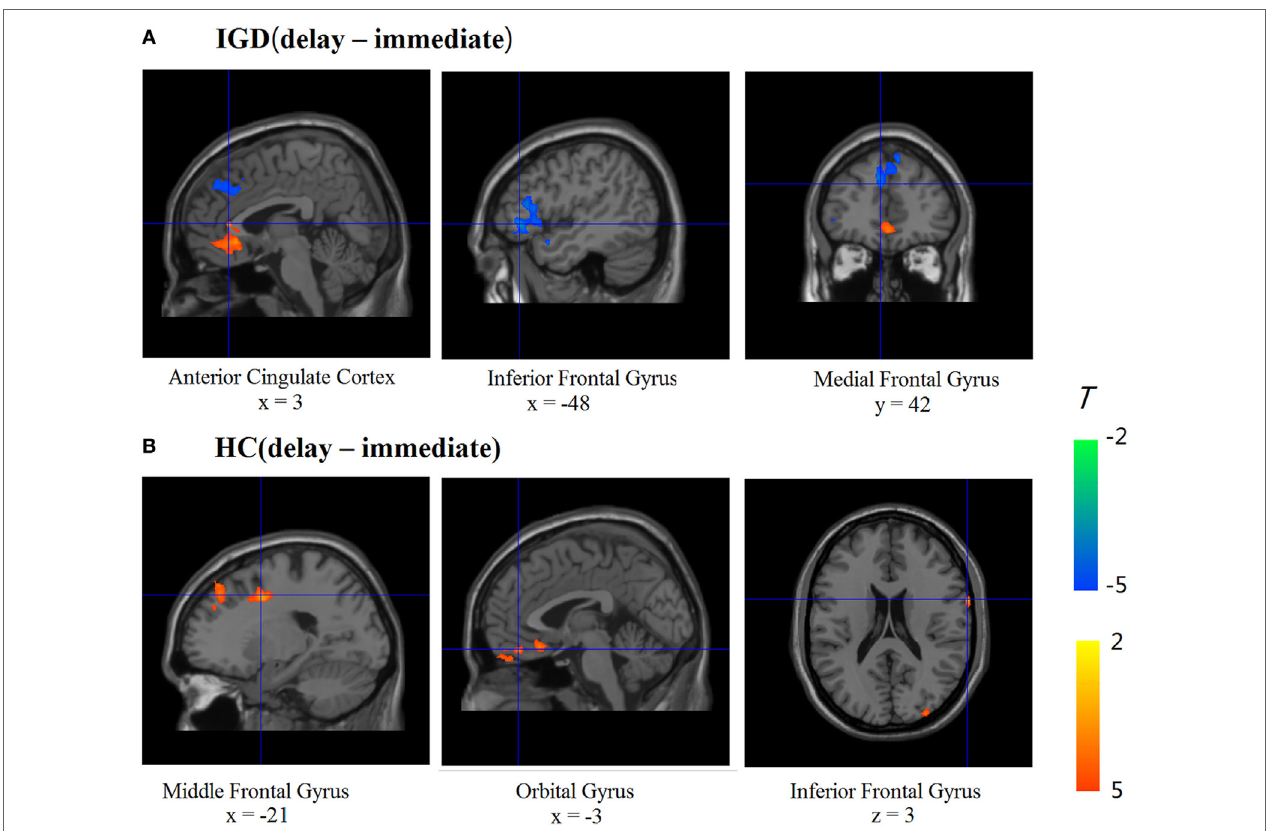
FigUre 5 | Brain activations change between different conditions in Internet gaming disorder (IGD) and healthy control (HC) (delay − immediate). (a) The IGD showed greater brain activation in the ACC and lower brain activations in the left inferior frontal gyrus (IFG) and medial frontal gyrus (delay > immediate). (b) The HC showed greater brain activations in the right IFG, orbital gyrus, and middle frontal gyrus (delay >